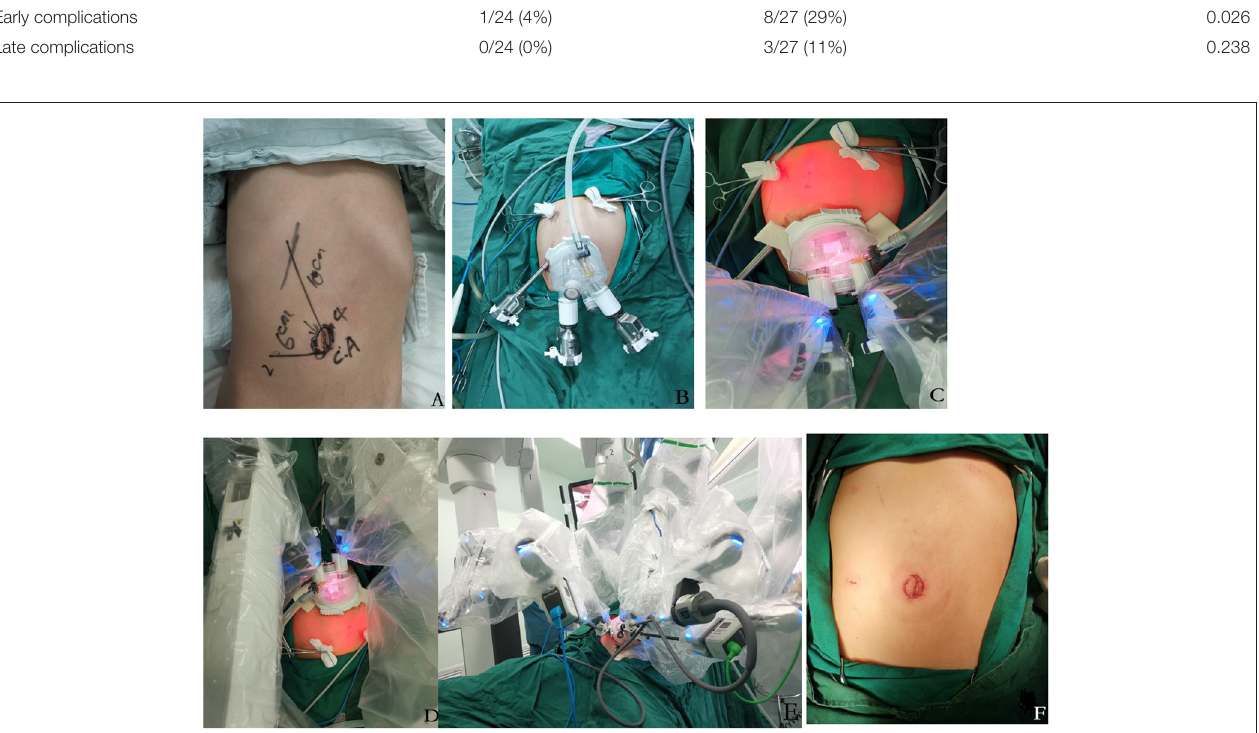
FIGURE 1 | (A–F) (A,B) the design location of quadruple-channel puncture device and port II. (C–E) after the docking of a robotic system, the distance between each robotic port was about 4cm, which was effectively avoiding instrument collision. (F) the cosmetic appearance of the wound of trans-umbilical single-site plus 1 robotic-assisted